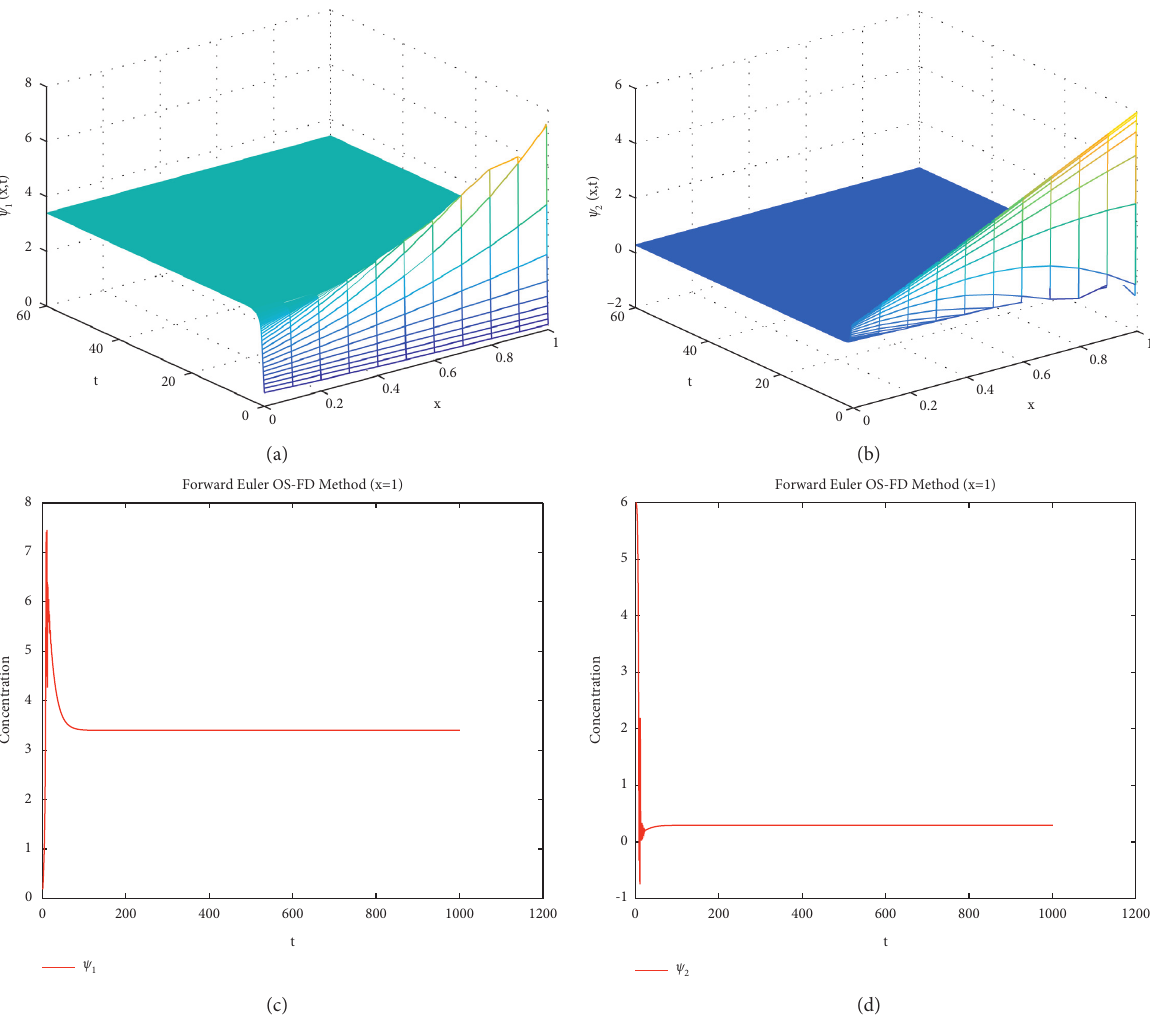
Figure 1: Mesh graphs and plot graphs of ψ � 1 , ϑ � 3 . 4 , λ � λ � 0 . 0006 , and ε κ � 0 . 1 , ϑ 1 2 1 2 Plot graph of ψ 2